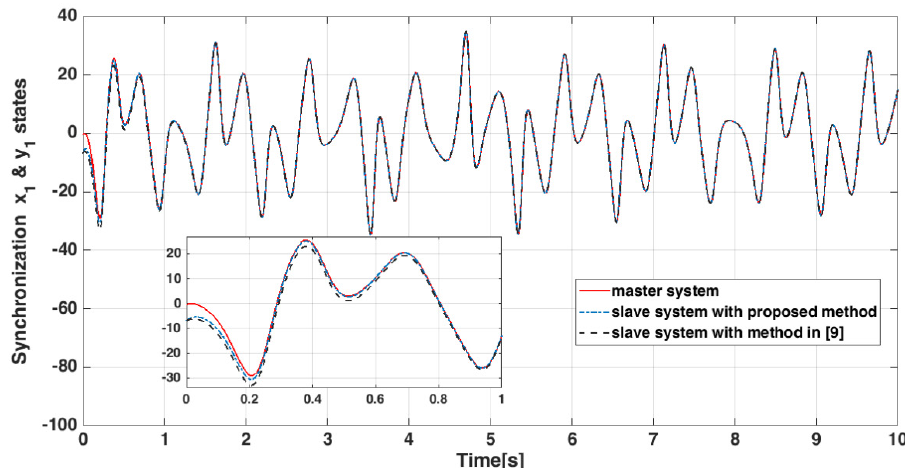
Figure 8. Time trajectories of states 𝒙 𝟏 and 𝒚 𝟏